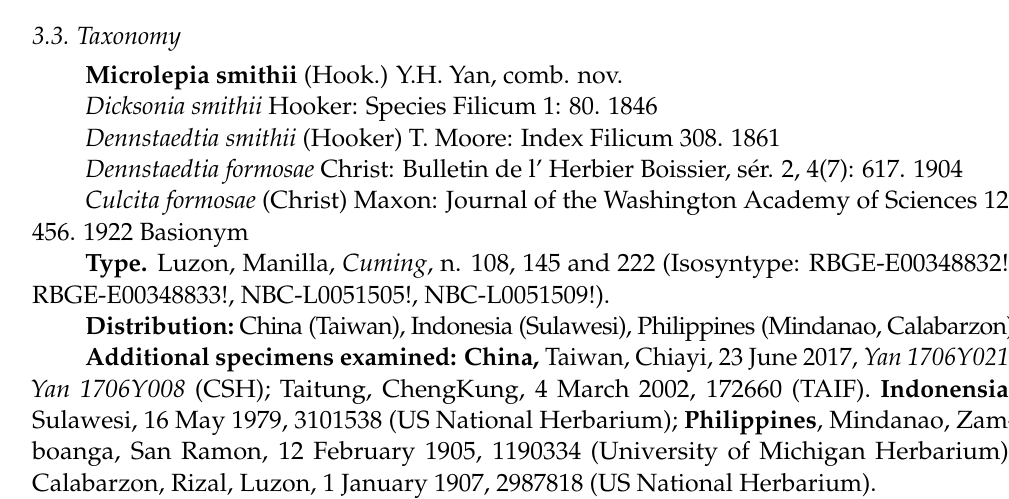
Figure 2. ( A ): Phylogenetic tree from ML and BI analyses of combined data from four chloroplast regions ( rbcL , rps4 , psbA-trnH and trnL-F ). Both analyses have the same topology. Dennstaedtia smithii and Microlepia speluncae (the type of Microlepia ) are marked in red text. Support values beside each node represent bootstrap support for ML (BSML) followed by posterior probabilities for BI (PPBI). Asterisks (*) indicate BSML = 100% and PPBI = 1.0. ( B ): The connection of costal grooves between rachis and pinna rachis of Microlepia and